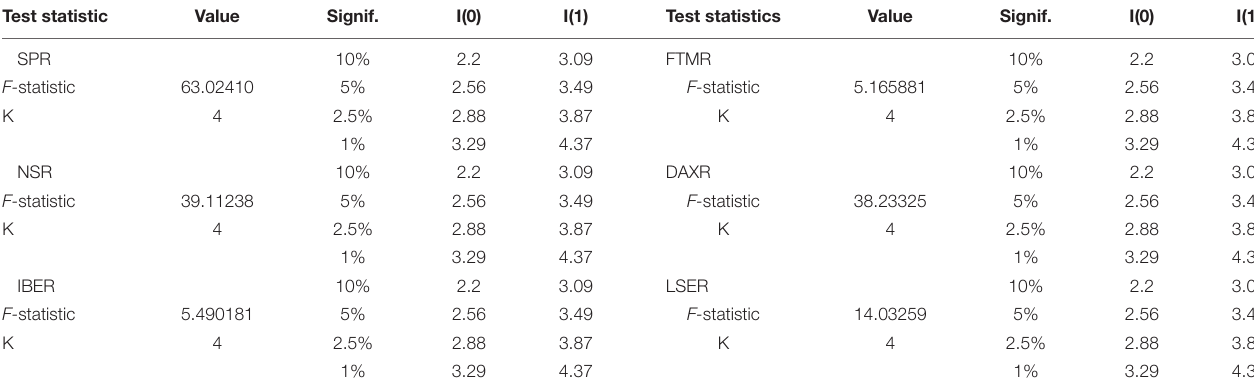
TABLE 3 | Results of F- bound test. Test statistic